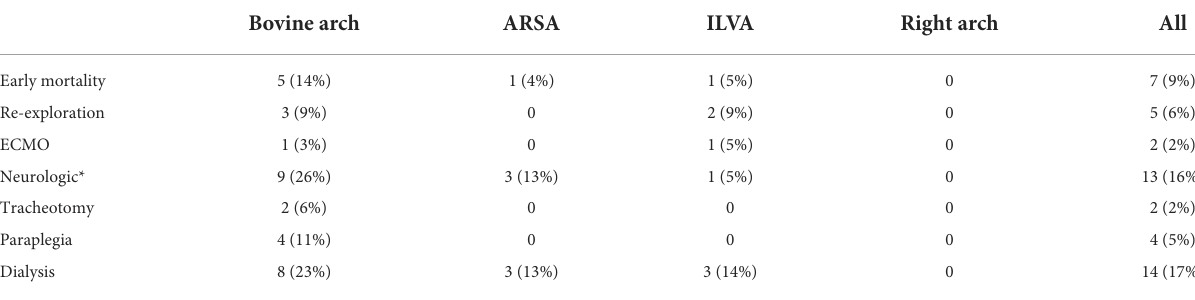
TABLE 4 Surgical